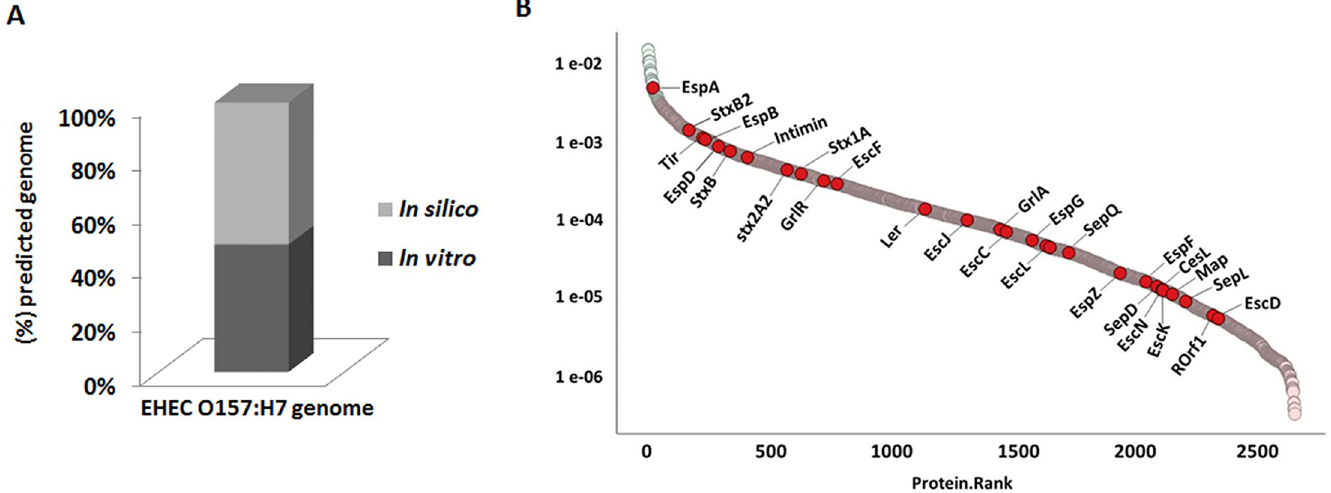
Fig 1. Characterization of EHEC O157:H7 proteome and correlation with in silico data. (A) Correlation of the proteomic results with in silico data of EHEC O157: H7 genome. (B) Dynamic range based on the emPAI value of the proteins identified by LC-MS analysis; pink, most abundant proteins; green, less abundant proteins and red, proteins related to EHEC O157:H7 and that are present in the LEE pathogenicity island.